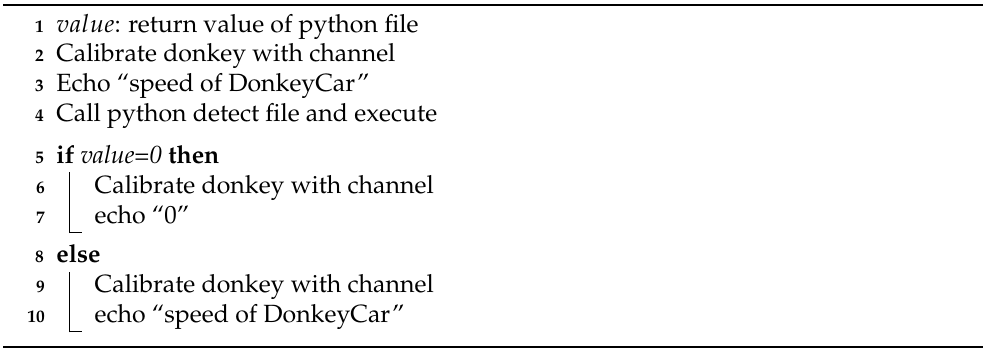
Algorithm 4: Pseudo code of donkeycar control algorithm.